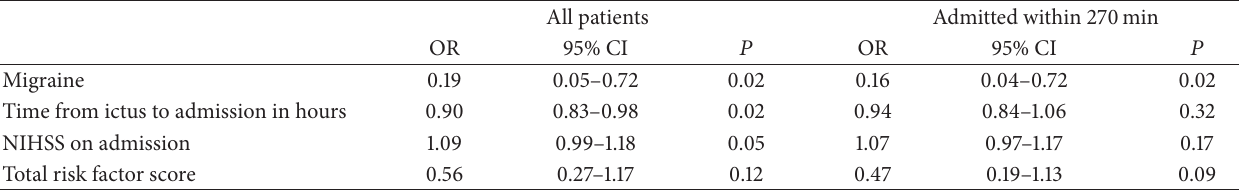
Table 3: Logistic regression analysis displaying factors associated with thrombolytic therapy (rTPA) in all young AIS patients and young AIS patients admitted within the thrombolytic time window.